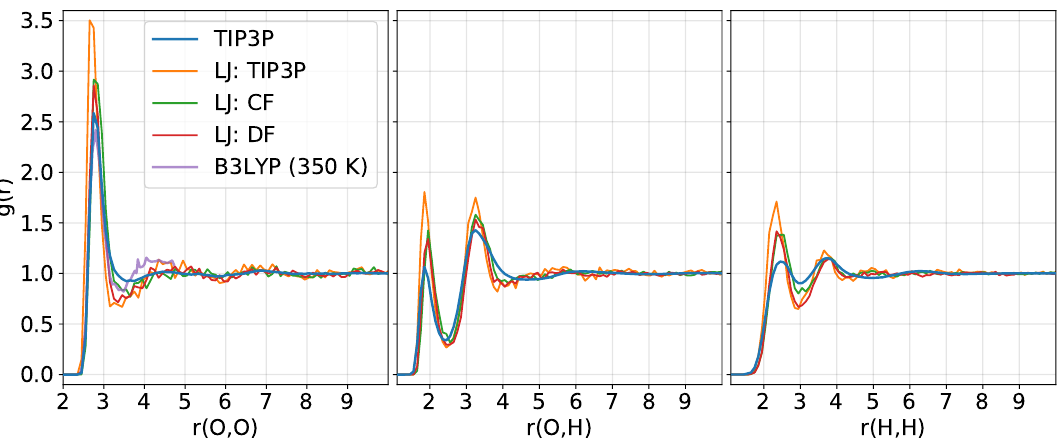
Figure A3. Pairwise O-O, O-H, and H-H radial distribution functions of liquid water at 300 K. The QM / MM RDFs are sampled from a single B3LYP water molecule in a box of 728 MM molecules. Three types of QM / MM simulations were made, one for each of the QM / MM LJ parameter sets: TIP3P, DF, and CF. The pure B3LYP data, simulated at 350 K, and for 32 water molecules was obtained from [36]. The higher temperature is known to lower the amplitude of the O-O peaks for both classical, pairwise force fields [54], and for DFT methodologies